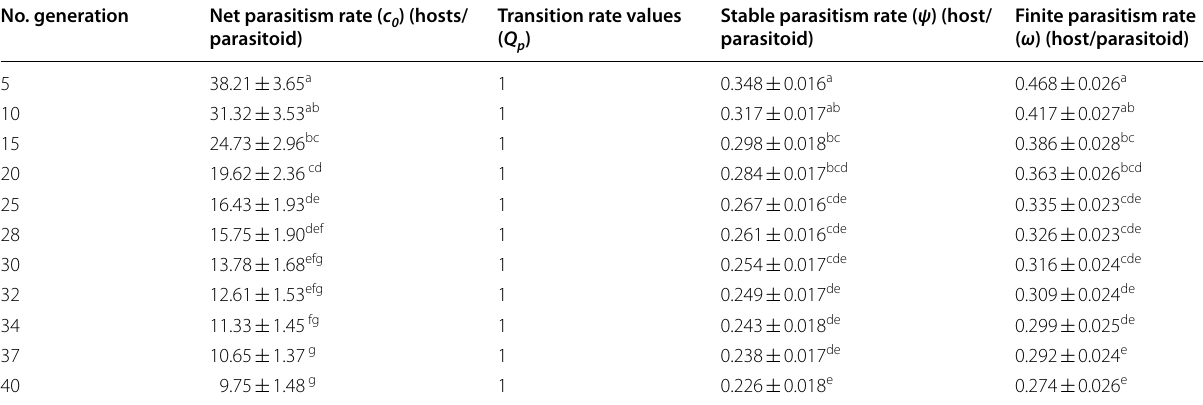
The means marked by the same letters within the same column are not significantly different (Paired-bootstrap test, P < 0.05)